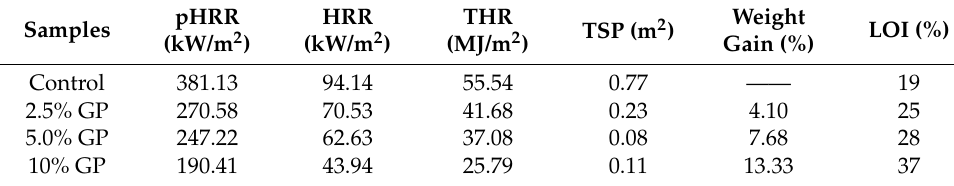
Figure 4. ( a ) HRR and ( b ) THR curves of the control wood and GP-modified wood. Table 2. LOI and cone calorimetry data of control wood and GP-modified wood.